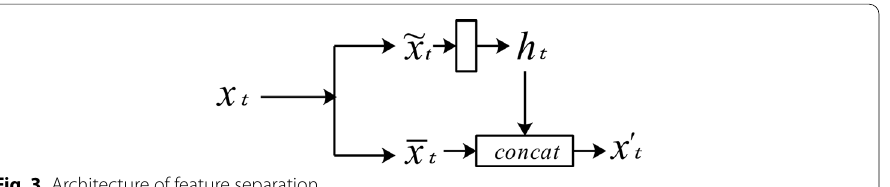
Fig. 3 Architecture of feature